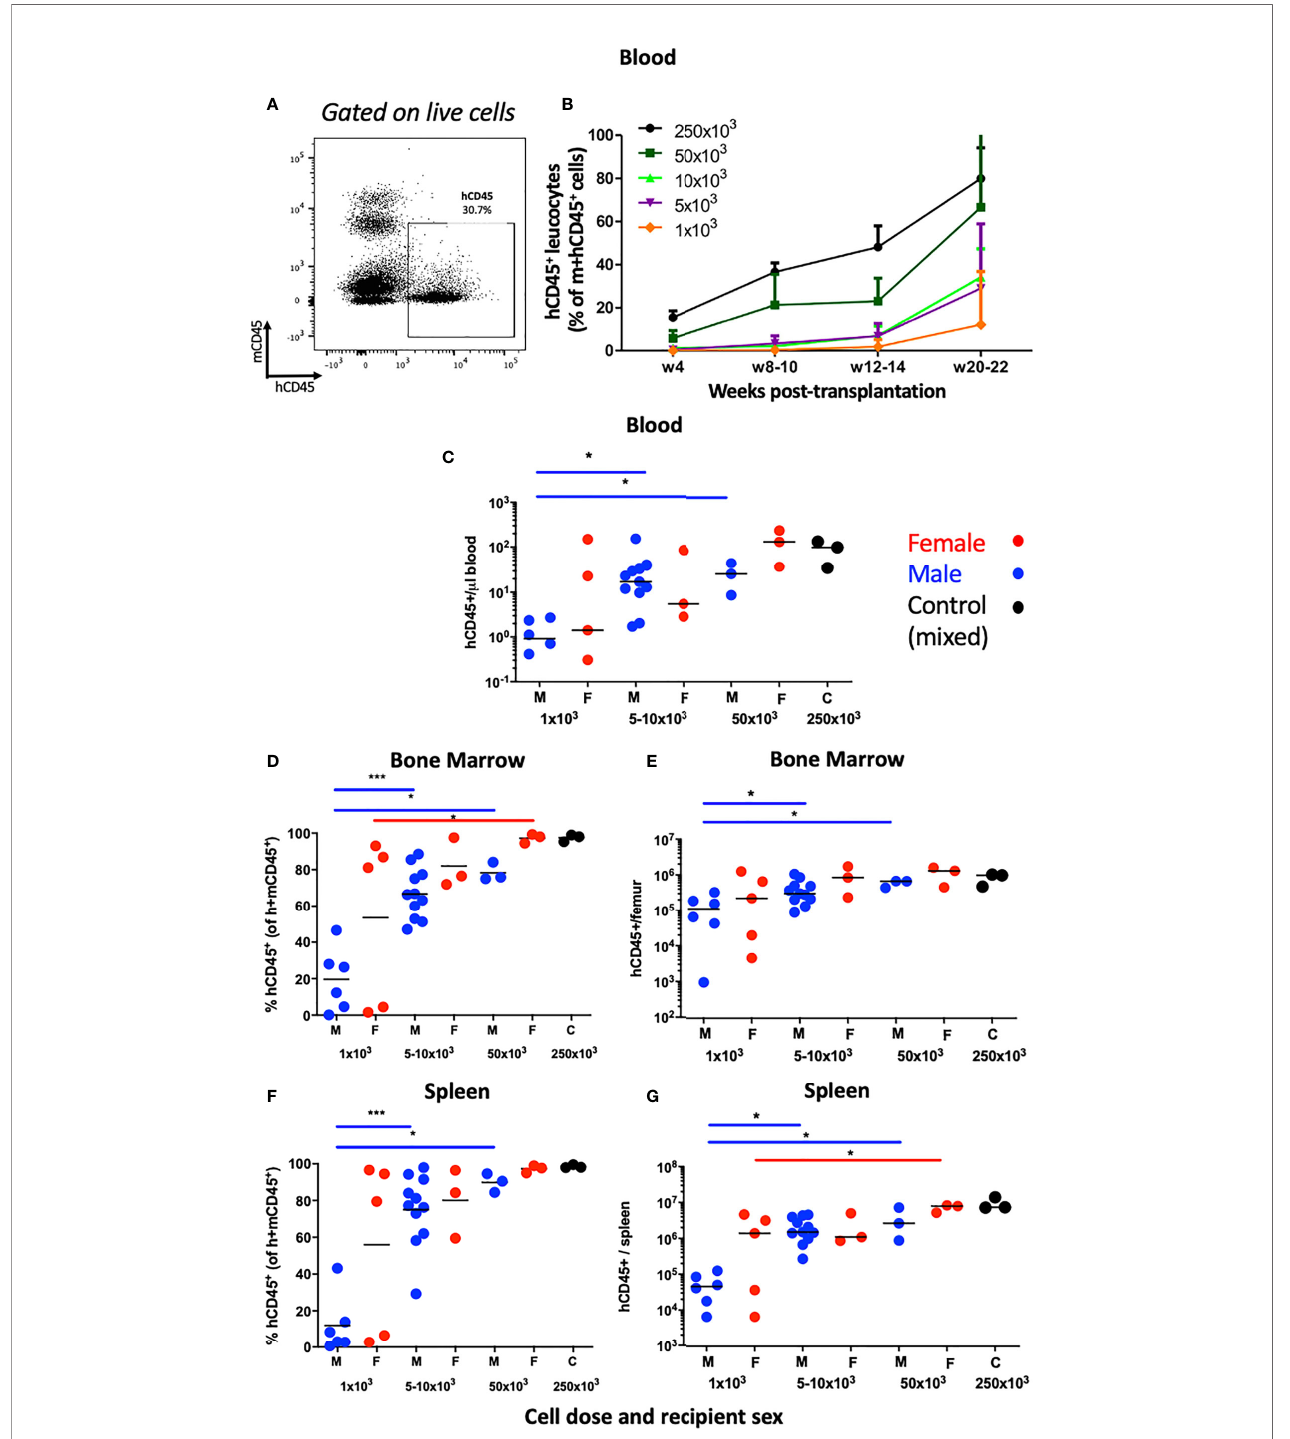
FIGURE 1 | Human leucocyte reconstitution in HSPC-NBSGW mice. (A) Representative fl ow cytometric analysis of mCD45 + vs hCD45 + cells in the peripheral blood of non-irradiated NBSGW recipients 20-22 weeks after i.v. injection with 1x10 3 hCD133 + hUCB HSPCs. (B) Frequencies of hCD45 + leucocytes in the blood at indicated time points according to dose of injected HSPCs (mean and SD shown). (C) Absolute numbers of human CD45 + leucocytes per microliter of blood in male and female recipient mice, based on number of injected HSPCs. (D – G) Human CD45 + leucocyte frequencies (percentage of total mouse plus human CD45 + cells) and corresponding absolute numbers per, bone marrow of one femur and spleen in male and female recipient mice, based on number of injected HSPCs. M- male (blue symbols), F- female (red symbols), 250x10 3 C – control group (mixed sex). Statistical signi fi cance was assessed using a Mann Whitney test (*p<0.05, ***p<0.001). In (C) , two points fall below the cut-off shown for 1x10 3 cells infused. Non-statistical bars represent median